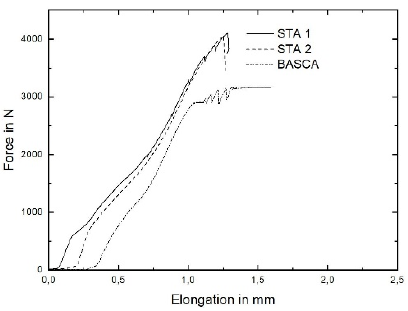
Figure 12. In situ force/elongation curves of heat-treated EB-PBF Ti-5553 alloy using EL = 600 J/m.